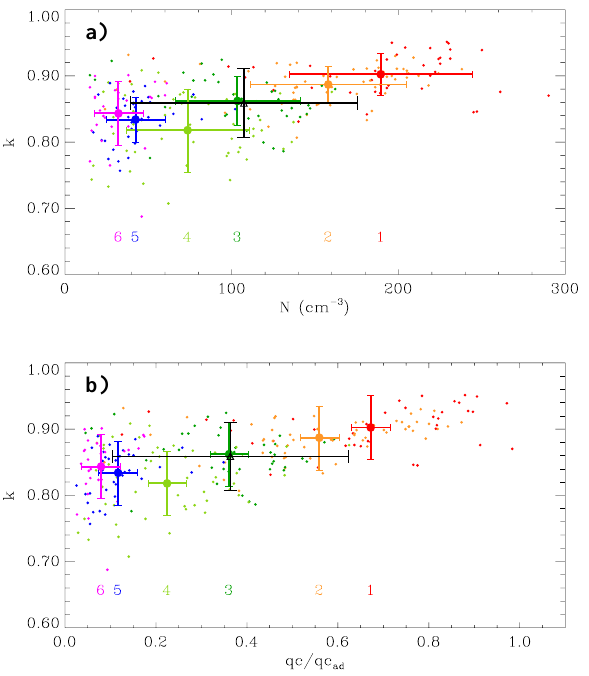
Fig. 3. Scatterplot of the 10Hz sample k factor values derived from Fast-FSSP data collected in a Cu during SCMS (points) as func- tion of (a) the total droplet number concentration and (b) the LWC adiabatic fraction. Mean value is indicated for each of the six cloud traverses performed in this turret (colour dot) and for the whole data set (black triangle). Error bars correspond to one standard deviation.